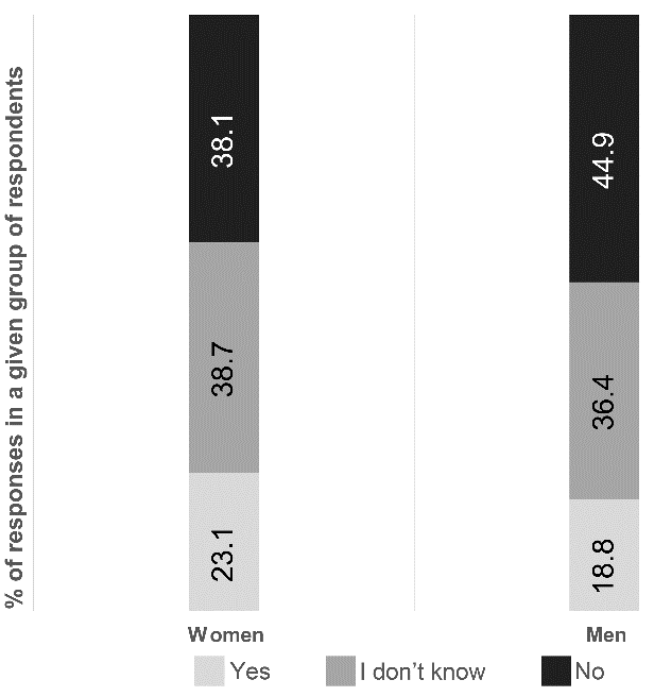
Figure 6. Willingness to change one’s own apartment for an apartment adapted to the needs of the disabled, depending on gender.